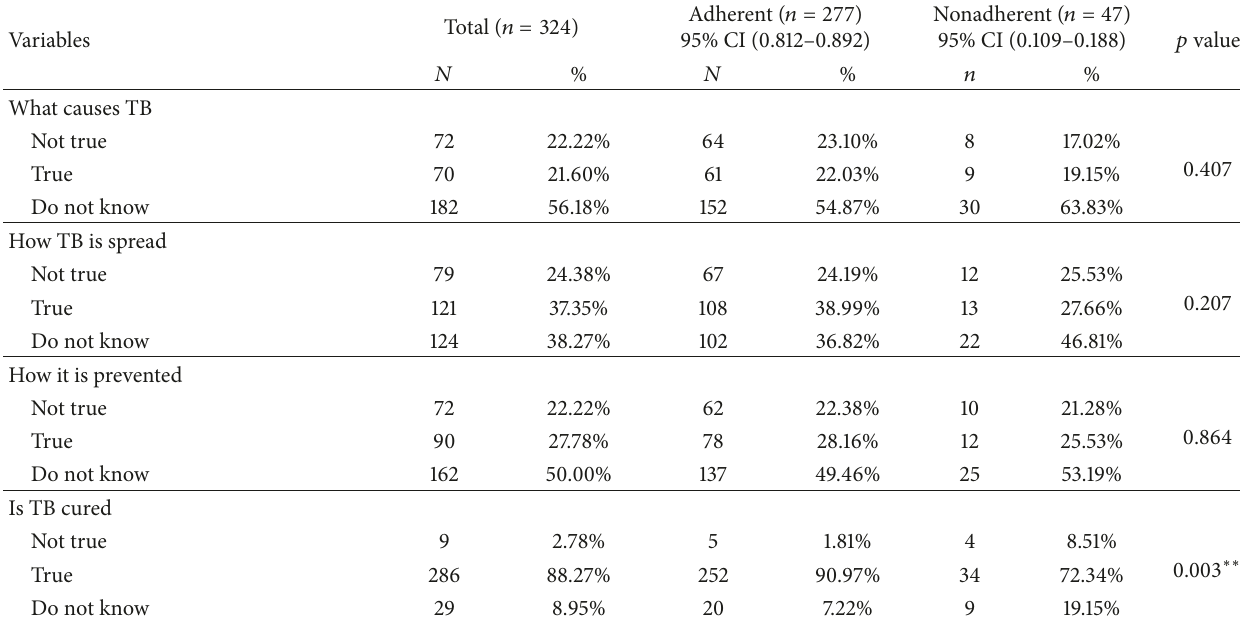
Table 2: Knowledge for TB disease.